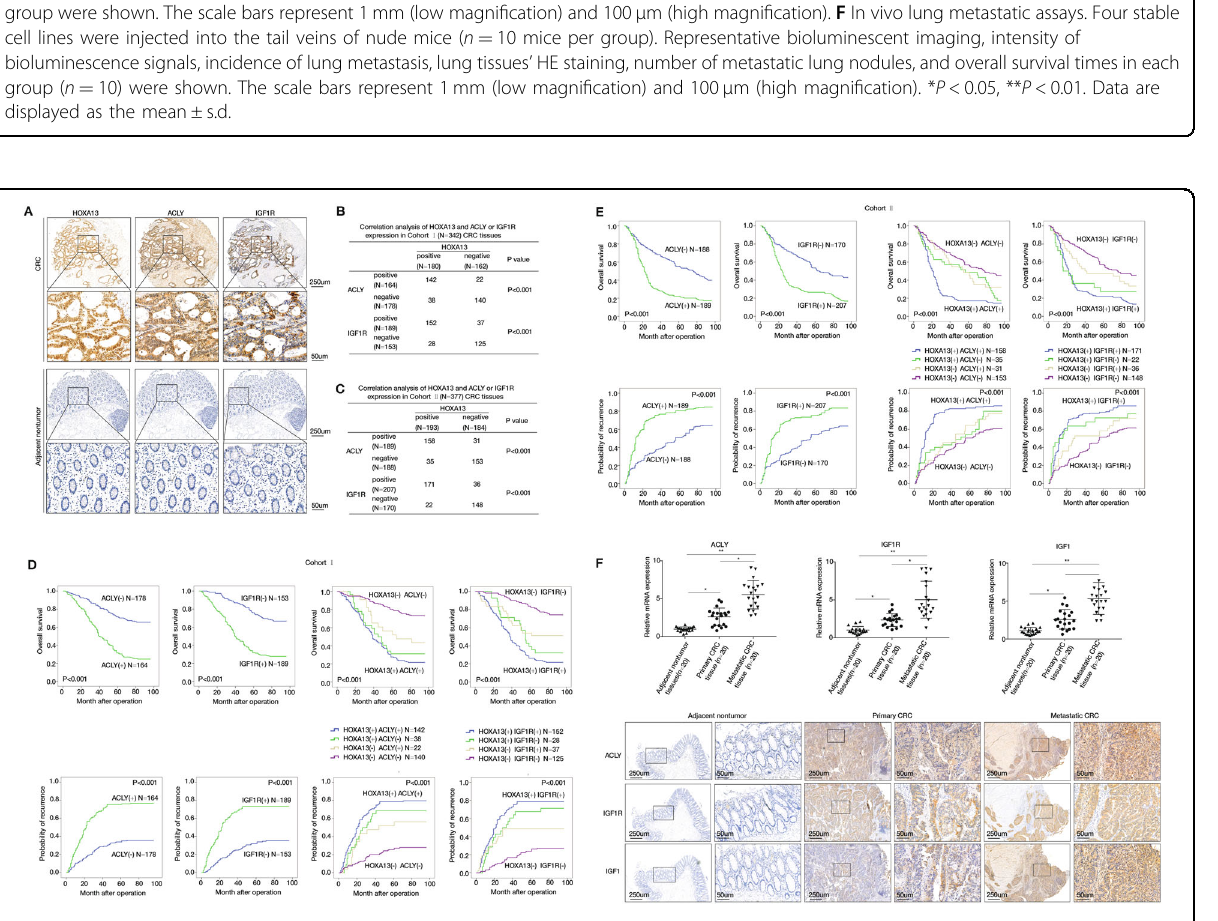
Fig. 5 HOXA13 expression has a positive correlation with ACLY and IGF1R expression in CRC tissues. A Representative images of IHC staining of HOXA13, ACLY, and IGF1R expression in human CRC and adjacent nontumor samples were shown. The scale bars represent 250 μ m (low magni fi cation) and 50 μ m (high magni fi cation). B , C Correlation analysis of HOXA13 and ACLY or IGF1R expression in the CRC tissues in cohort I ( B ) and cohort II ( C ). D , E Kaplan – Meier ’ s curves generated with the data from the CRC patients with negative versus positive ACLY or IGF1R expression. The correlation between HOXA13 and ACLY (left) or IGF1R (right) expression and overall survival or recurrence in patients with CRC in cohort I ( D ) and cohort II ( E ). F Real-time PCR (upper) and IHC analyses (lower) of ACLY, IGF1R, and IGF1 expression in adjacent nontumor samples, primary CRC, and paired metastasis CRC samples. The scale bars represent 250 μ m (low magni fi cation) and 50 μ m (high magni fi cation). * P < 0.05, ** P < 0.01. Data are displayed as the mean ±